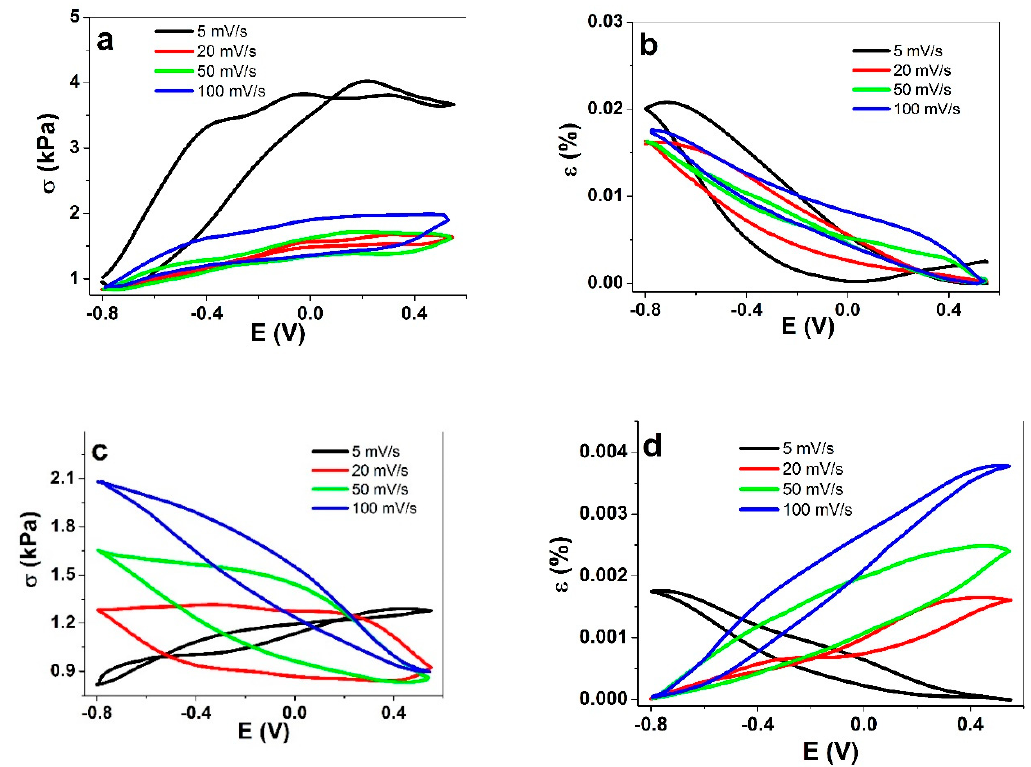
Figure 3. Cyclic voltammetric measurements (3rd cycles) of Cell-CNT fibers (the working electrode) at di ff erent scan rates (5 mV s − 1 (black); 20 mV s − 1 (red); 50 mV s − 1 (green) and 100 mV s − 1 (blue)) operated in a three-electrode setup with an Ag / AgCl (3M KCl) reference electrode and a platinum sheet counter electrode. The stress of Cell-CNT in LITFSI-aq is shown in ( a ) and the strain in ( b ). Cell-CNT in LiTFSI-PC electrolyte presents stress in ( c ) and strain in ( d ) against the applied potential range from 0.55 V to − 0.8 V.